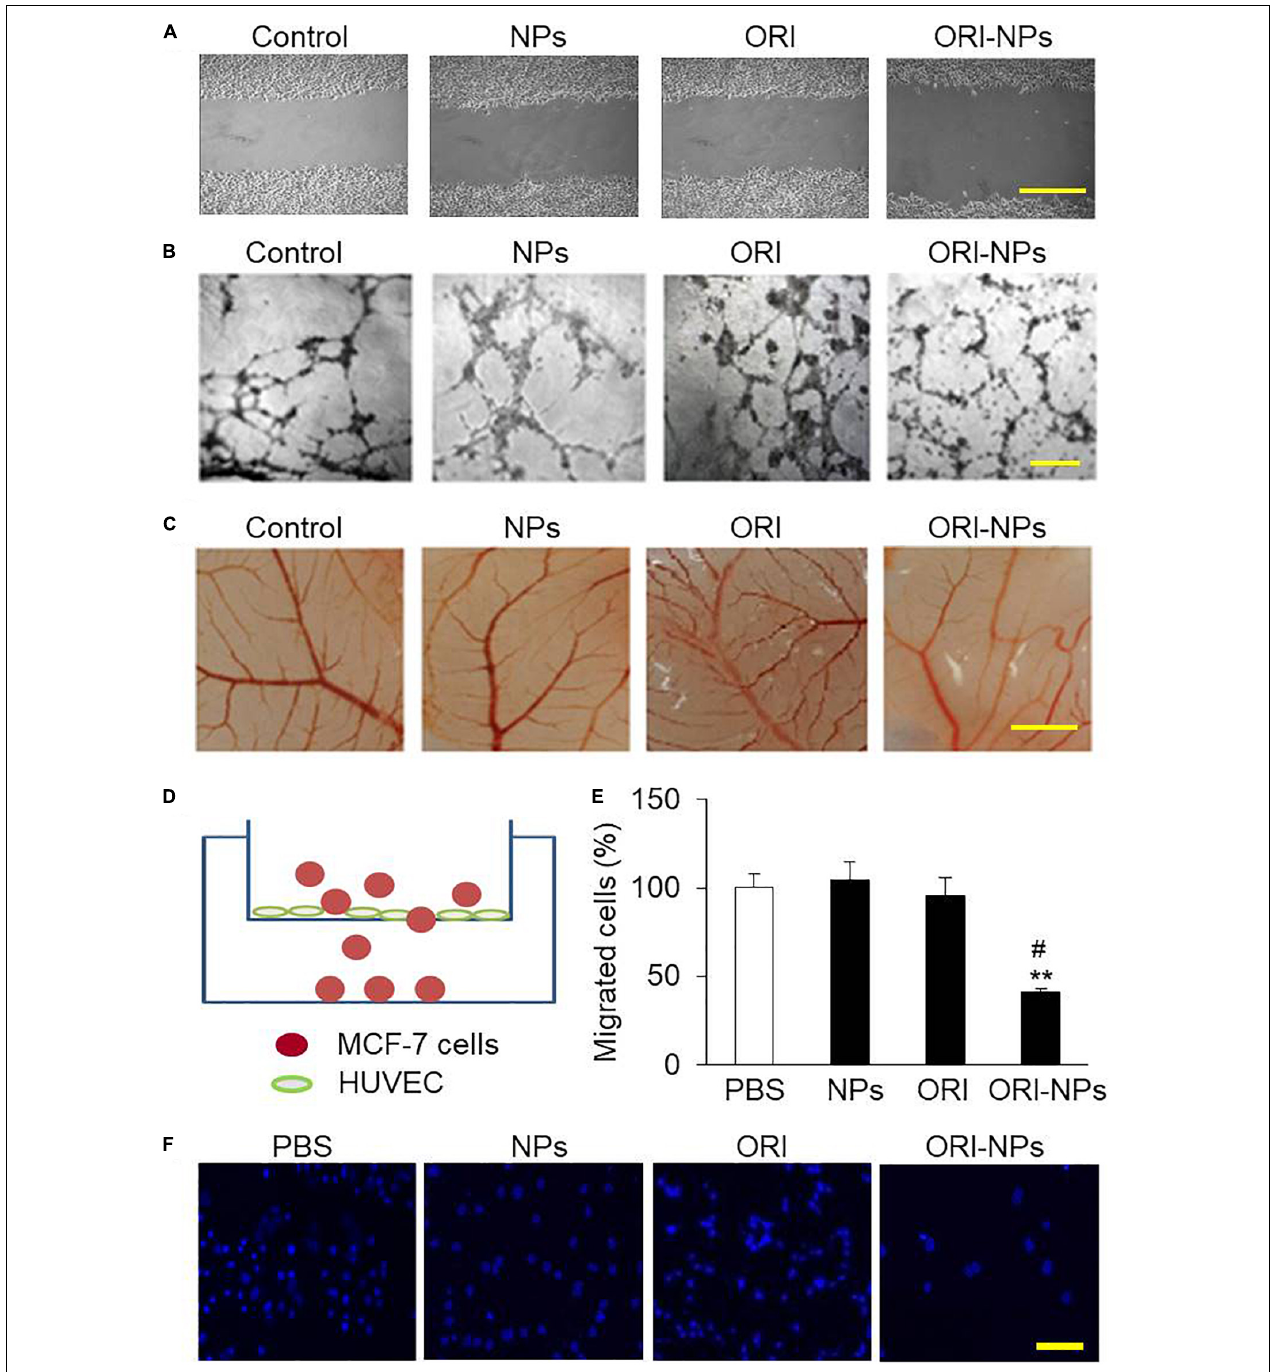
FIGURE 5 | ORI-NPs inhibits angiogenesis and transendothelial migration of MCF-7 cells. (A) Wound healing assay demonstrating that ORI-NPs inhibited HUVEC migration. After a total of 1 × 10 5 HUVEC seeded on 6-well plates obtained confluence, the cell monolayers were treated with PBS, blank NPs, free ORI or ORI-NPs. Then a wound was generated by a scrape with a pipette tip in each well. At 24 h after the scratch, the images of the cell monolayers were captured. Scale bar = 50 µ m. (B) Representative micrographs of endothelial cell tube formation of HUVEC showing the reduced tube formation by ORI-NPs. Scale bar = 50 µ m. (C) Representative micrographs of vessel branches in CAM models showing the inhibitory effects of ORI-NPs on angiogenesis. After the incubation for 7 days, the images of CAM were captured. Scale bar = 500 µ m. (D) Diagram of transwell experiment. (E) Representative micrograph showing less migrated MCF-7 cells following ORI-NPs treatment. After the migrated cells in the lower chamber were fixed and stained with DAPI, the photographs were acquired. (F) Quantification of number of migrated MCF-7 cells after the treatment with PBS, black NPs, ORI or ORI-NPs. Scale bar = 20 µ m. (Data were representative three independent experiments. * P < 0.05 and ** P < 0.01 versus PBS; # P < 0.05 versus